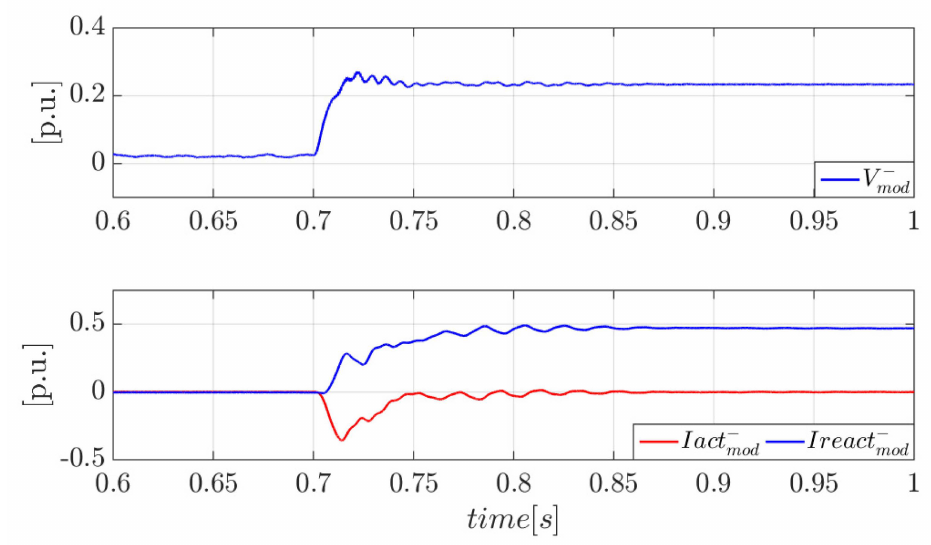
Figure 21. GFM converter negative sequence voltage and currents during an unbalanced fault with 0.23 p.u.